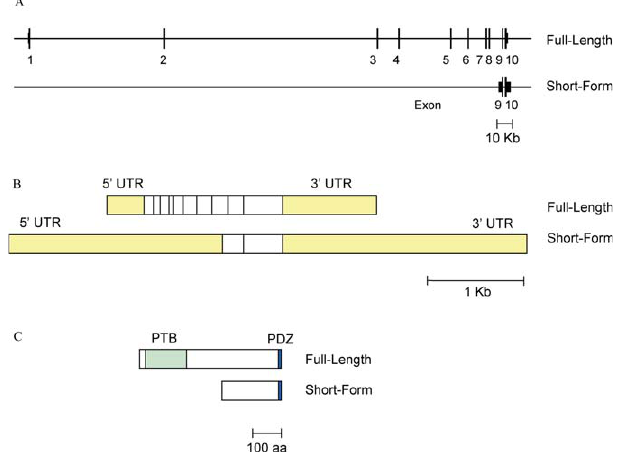
Figure 1. CAPON Gene Structure, Isoforms, and Protein Functional Domains CAPON full-length transcript and protein illustrations are based on NCBI reference sequences.